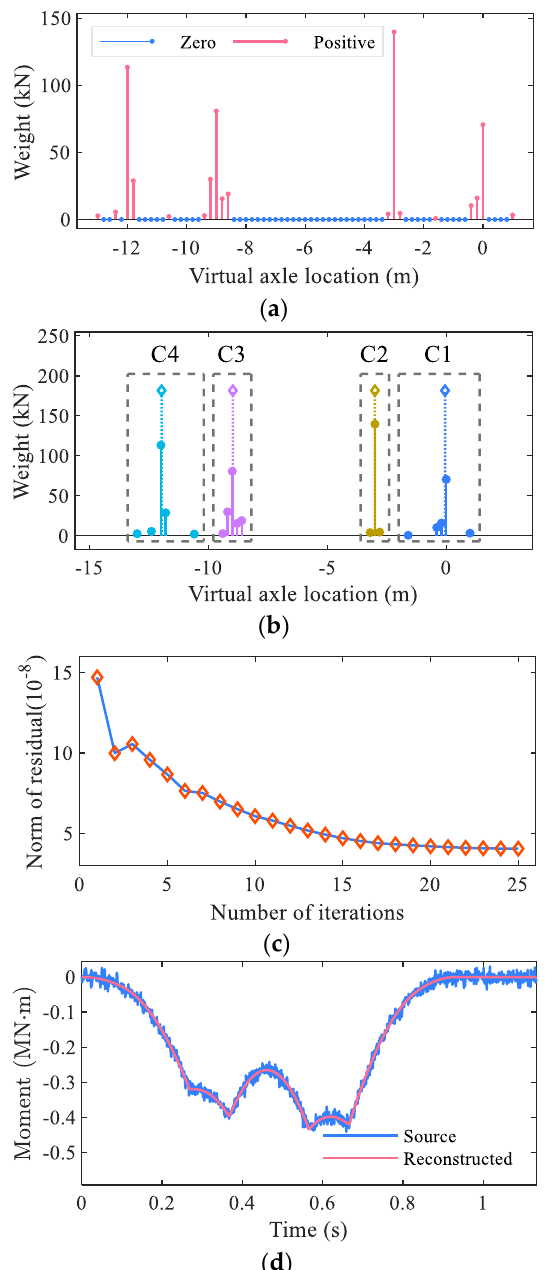
Figure 3. Bridge bending moment of the continuous bridge (4-axle vehicle, GVW = 550 kN).